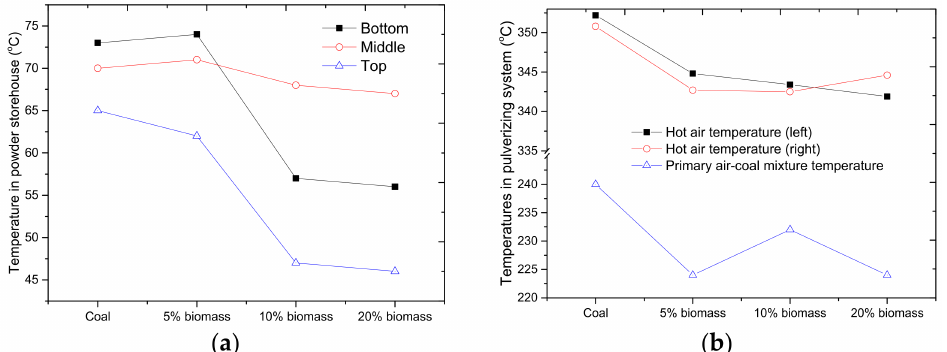
Figure 4. Temperatures in ( a ) powder-storage and ( b ) transporting system.